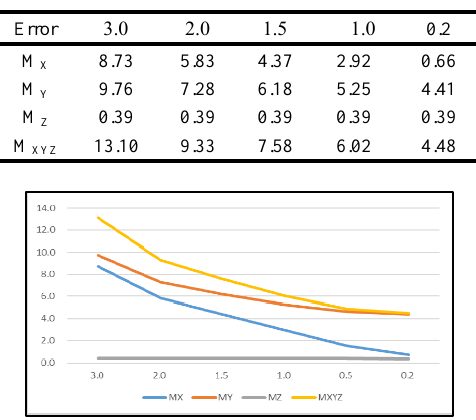
Figure 4. Influence of attitude measurement error